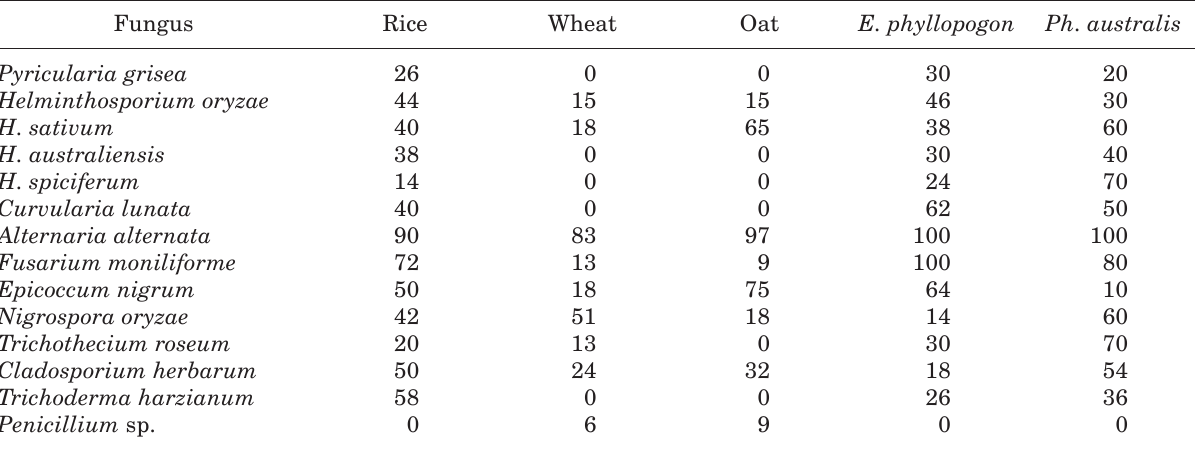
Table 1. Contamination percentage (Cp in %) of leaf lesions on rice, wheat, oat, Echinochloa phyllopogon and Phrag- mites australis caused by the different fungi identified.